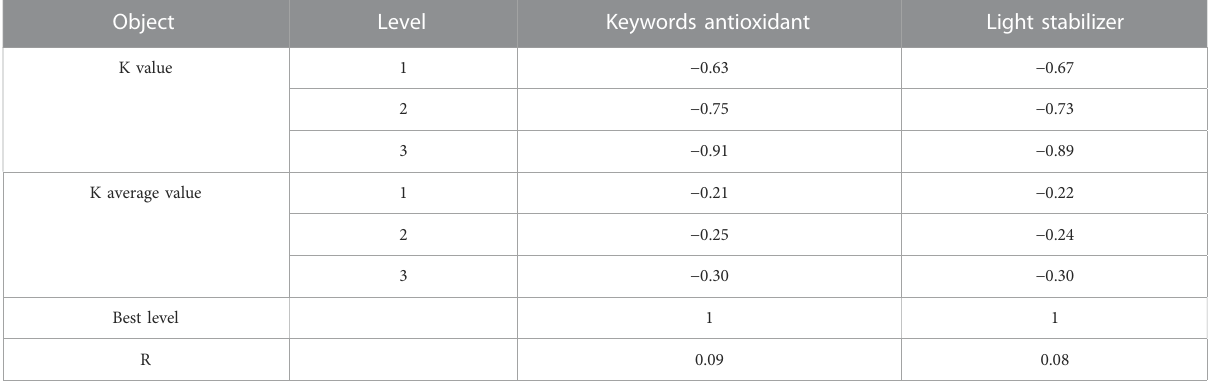
TABLE 12 Analysis of the quality loss